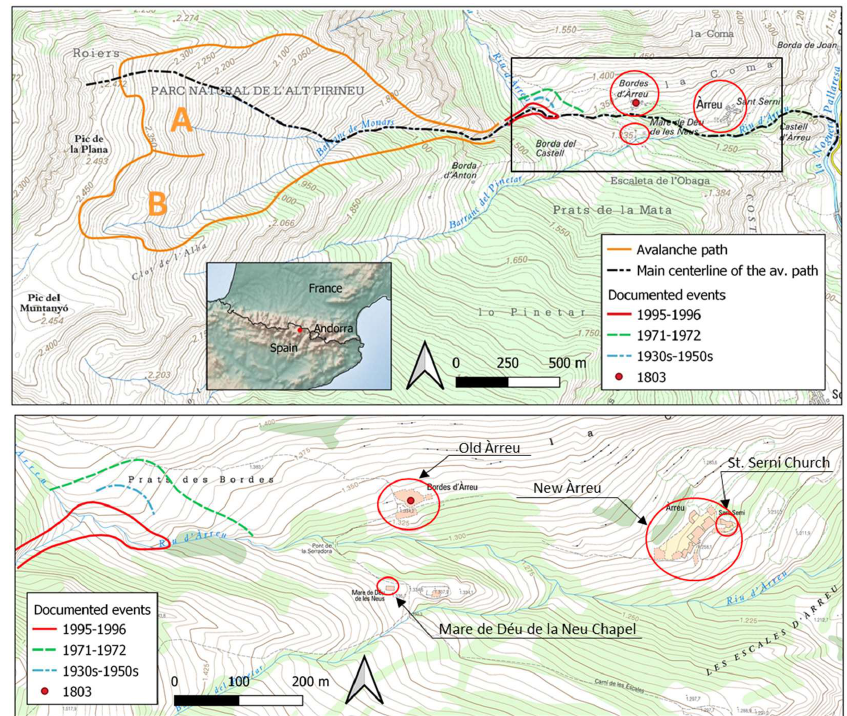
Figure 1. Location of the study site: The hamlets of Bordes d’Àrreu (old Àrreu) and Àrreu (new Àrreu); Barranc de Monars (Monars stream), Àrreu and Noguera Pallaresa rivers, and la Plana and Muntanyó peaks. The Monars avalanche path is drawn in orange (ARR010, modified from BDAC-ICGC), and main starting zones (A and B) and major avalanche events are identified. Geosciences 2020 , 10 , x FOR PEER REVIEW